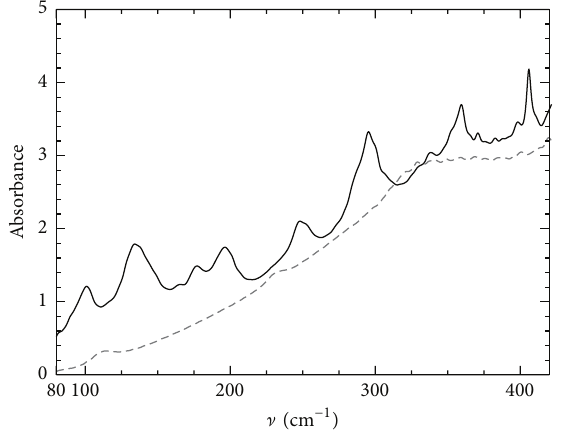
Figure 3: FTIR spectrum in the spectral range from 80 cm −1 to 420 cm −1 . The solid line corresponds to N -acetyl-D-glucosamine dispersed in polyethylene powder at 18wt% and the dashed line to a reference pellet of pure polyethylene of similar thickness.